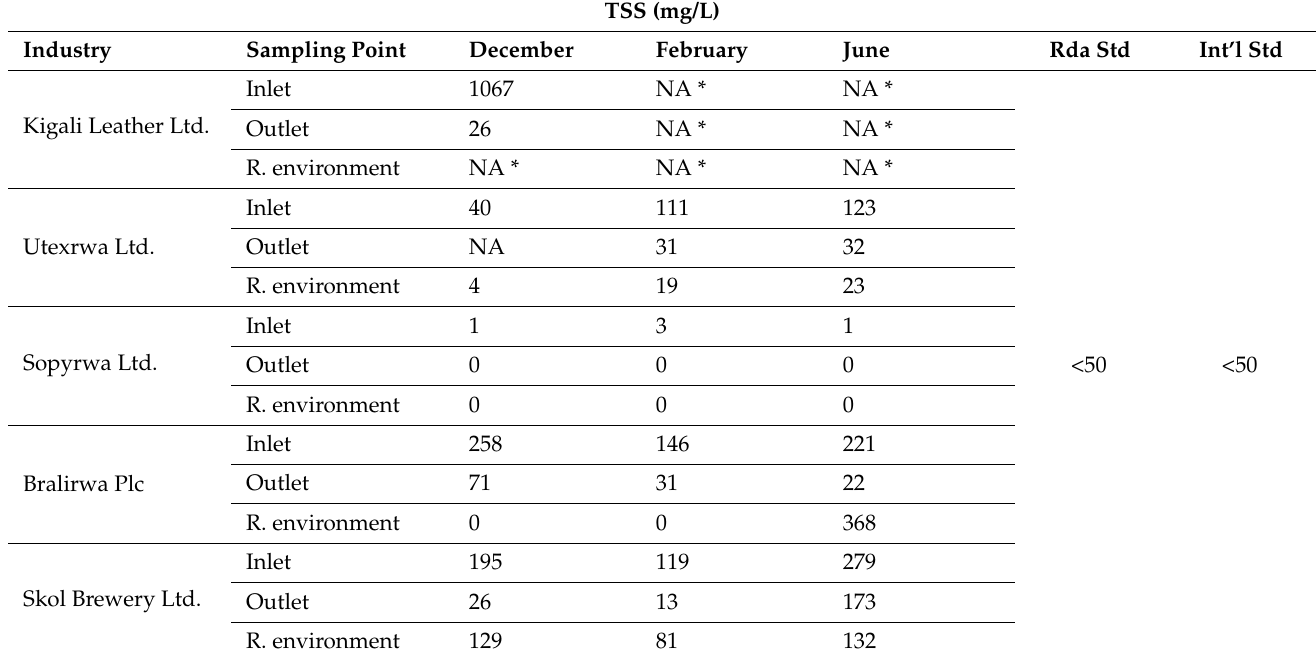
Table 6. TSS results for the selected